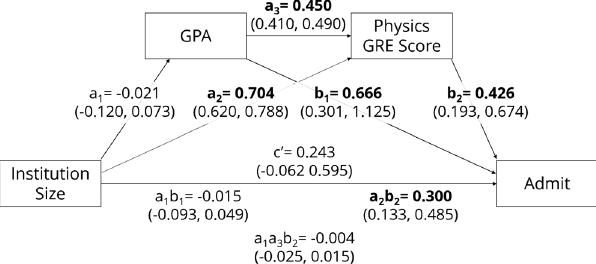
FIG. 12. Visual representation of the bootstrapped coefficients in Eqs. (5) to (7). We do find evidence of the physics GRE score mediating gender and admission status but do not find evidence of GPA mediating gender and admission status. We do not find evidence of a serial mediating relationship. Statistically signifi- cant coefficients are in bold. a b 2 2